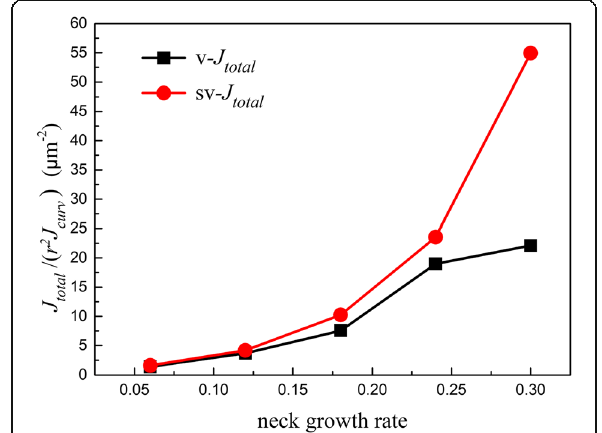
Fig. 8 Comparison of total diffusion flux under volume and simultaneous